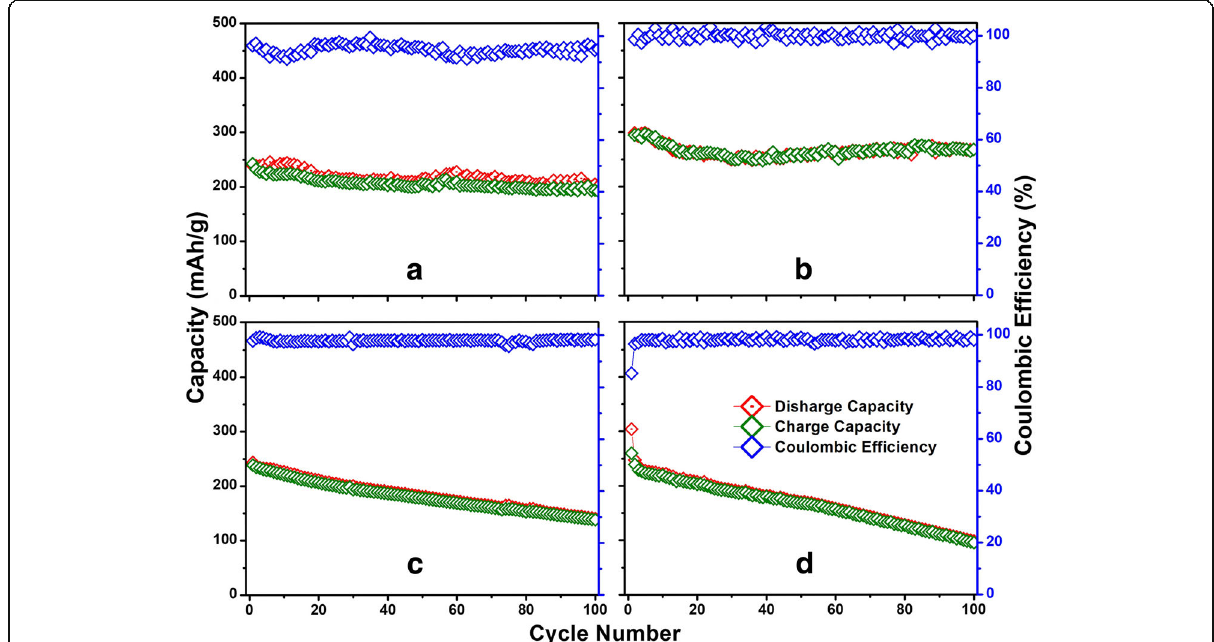
Fig. 5 Li-ion battery cyclic performance of a-VOx-6 Pa ( a , b ) in comparison with bulk c-V 2 O 5 ( c , d ) in the voltage windows 2.0 – 4.0 V ( a , c ) and 1.5 – 4.0 V ( b , d